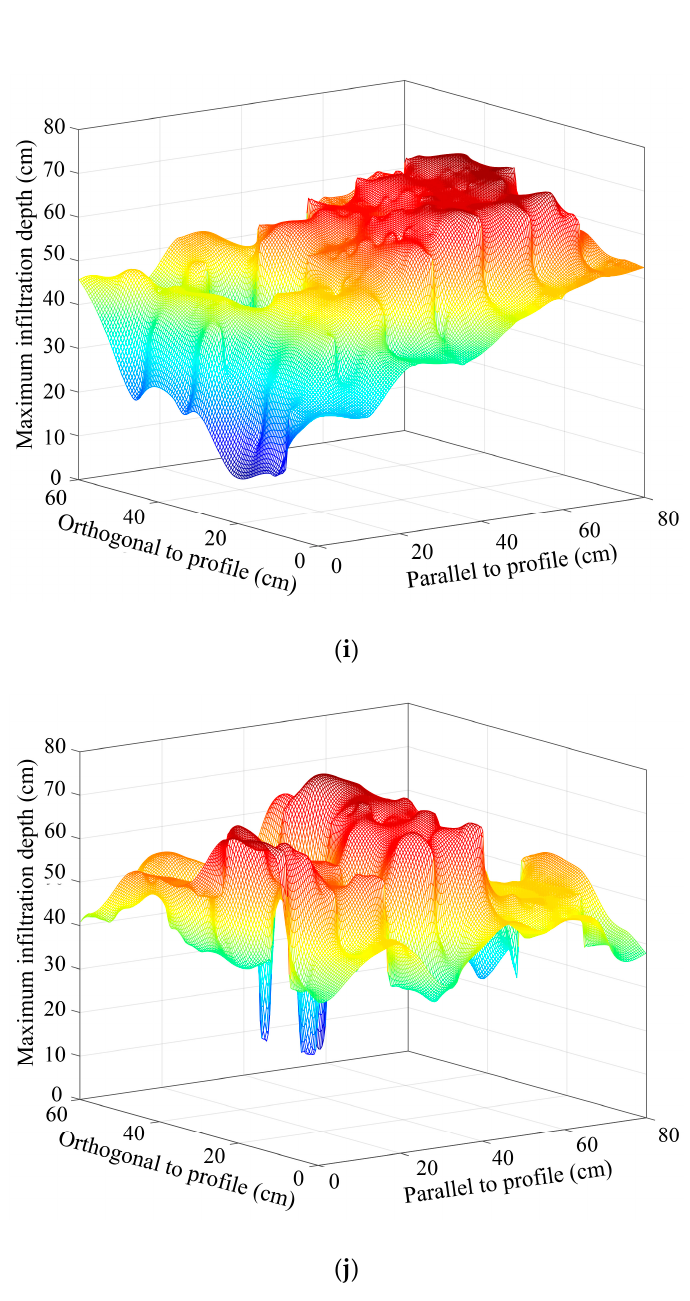
Figure 7. Spatial distribution of infiltration depth under different infiltration situation. The ground surface of each test area is discretized into a square grid of 0.1 cm × 0.1 cm, thereby obtaining 4.8 × 10 6 square grids for each experiment. MATLAB software was used to draw the plots of each experimental infiltration depth distribution. Plots showing ( a – e ) BBFCF tracer for hillslope positions A–E, respectively, ( f – j ) KI starch tracer for hillslope positions A–E, respectively.